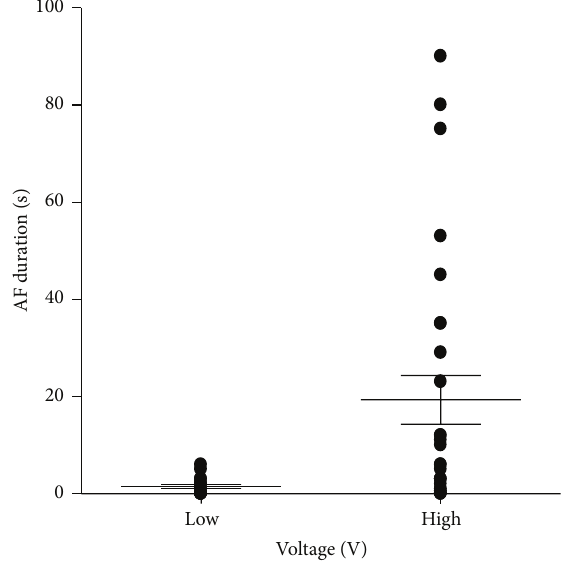
Figure 4: Duration of atrial fibrillation (AF) in low (5V, low) and high (20 V, high) voltage stimuli. Horizontal lines indicate median